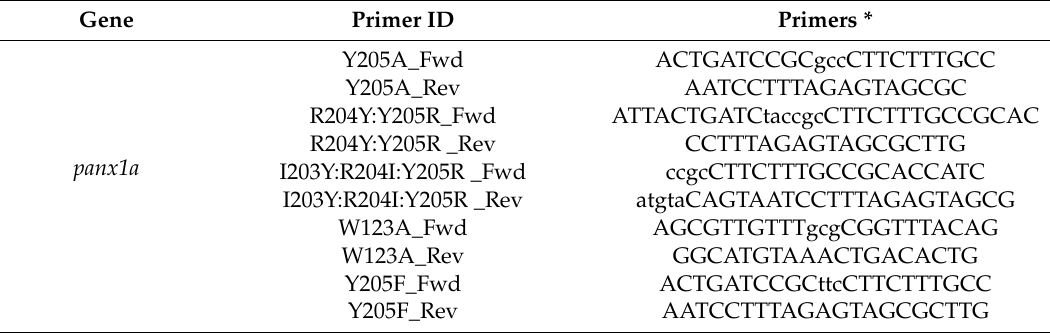
Table 1. List of primers for panx1a